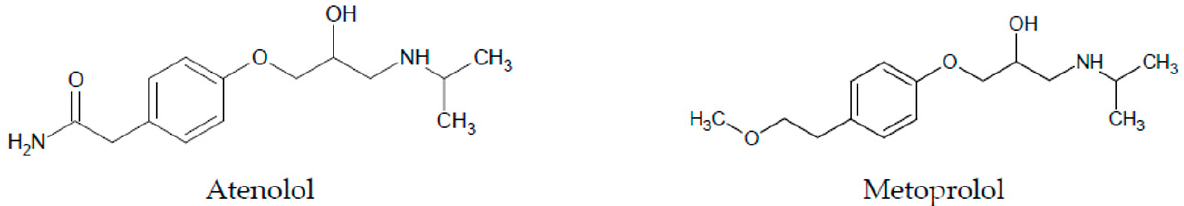
Figure 1. Structures of atenolol and metoprolol.